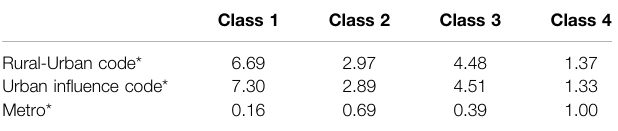
TABLE 13 | Means for urban/rural variables by latent class.